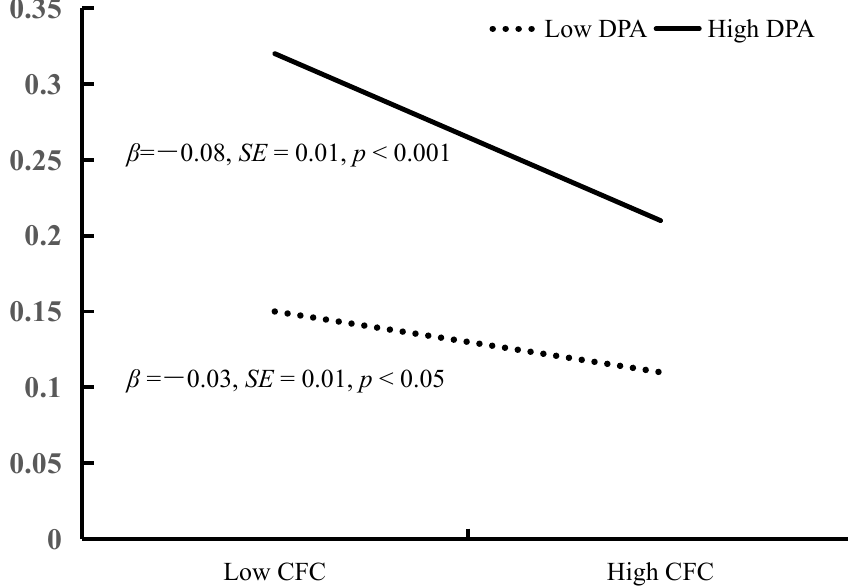
Figure 3. YDQ among adolescents as a function of CFC and DPA. Note: BSCS = Brief Self-Control Scale, CFC = Consideration of Future Consequences Scale, DPA = Deviant Peer Affiliations Scale, YDQ = Young’s Diagnostic Questionnaire.